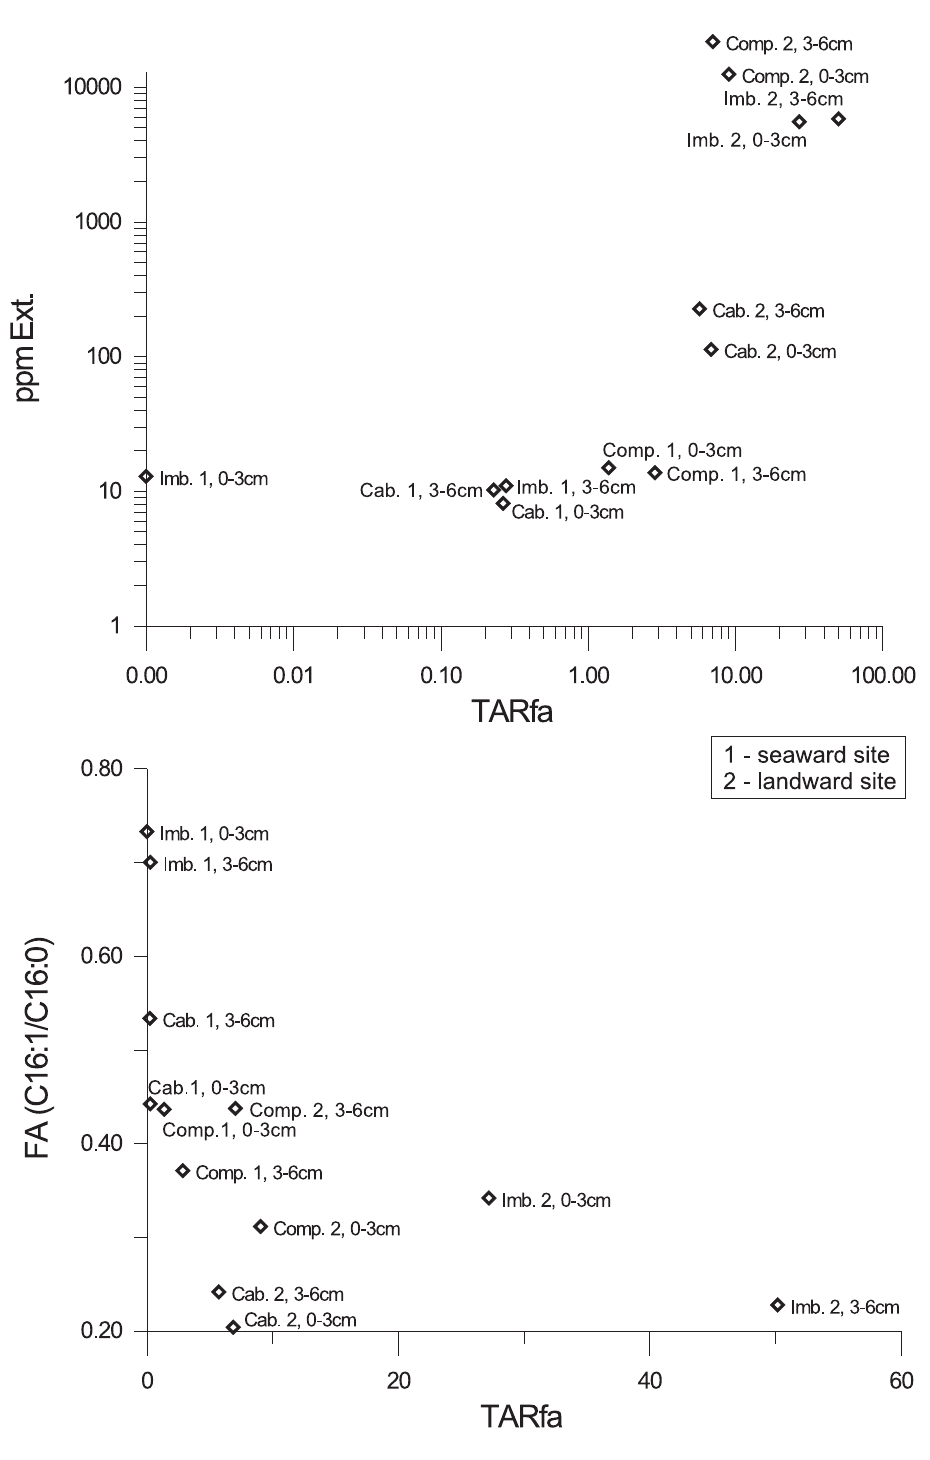
An Acad Bras Cienc (2004) 76